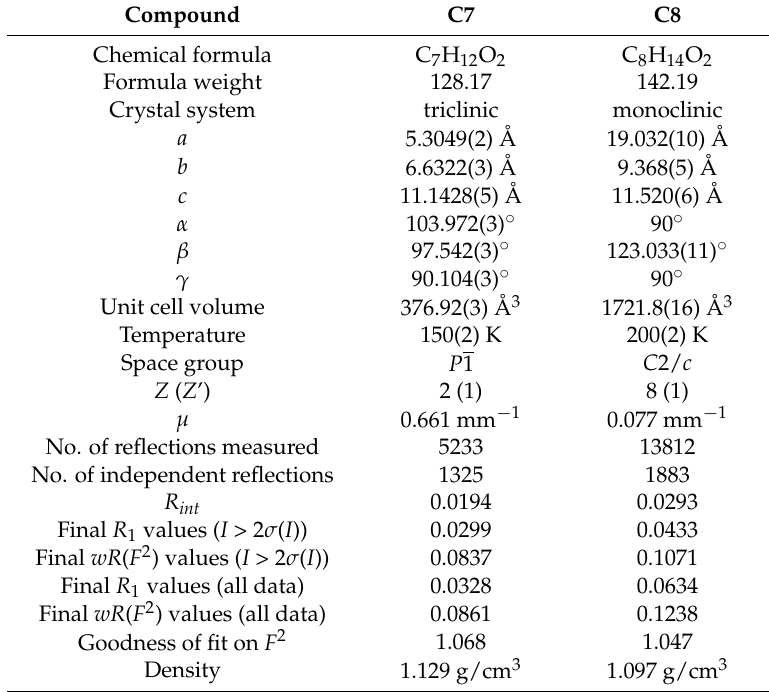
Table 1. Crystal data and structure refinement for C7 and C8 .